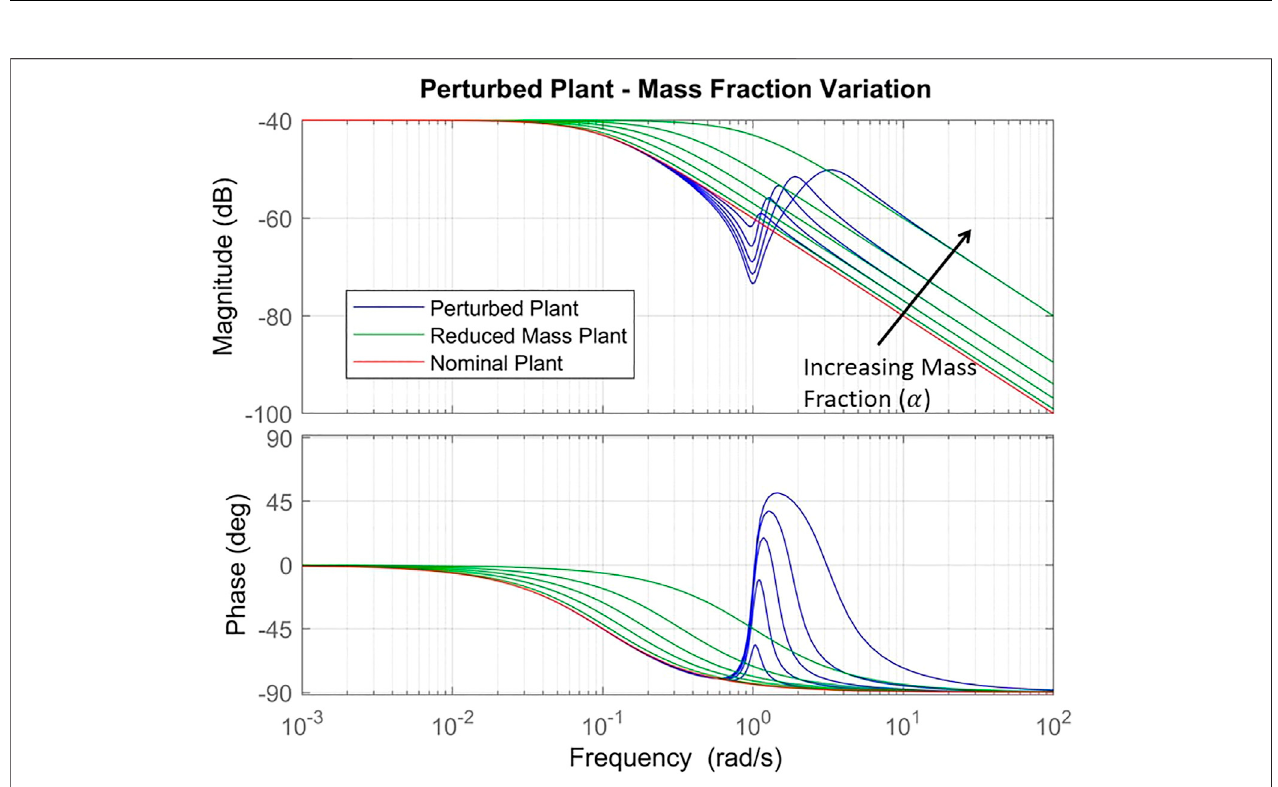
FIGURE 4 | Perturbed plant transfer function is shown (blue) for α ∈ {0.1,0.3,0.5,0.7,0.9} and fi xed damping ξ (cid:2) 0.1. The nominal plant is shown (red) as well as the nominal plant with inertia reduced to M 1 (green). Black arrow indicates direction of increasing mass fraction α .